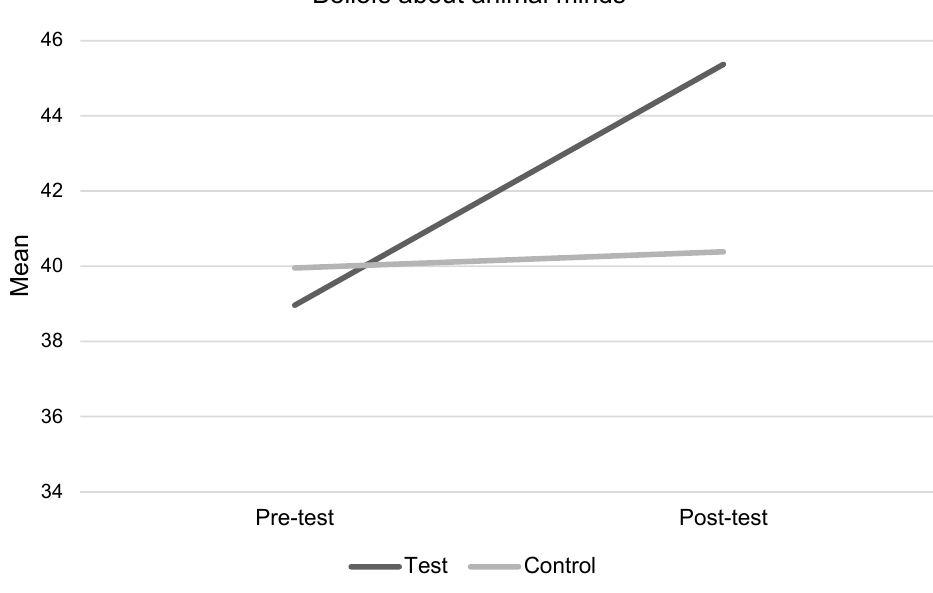
Figure 3. Children’s beliefs about farm animal minds.